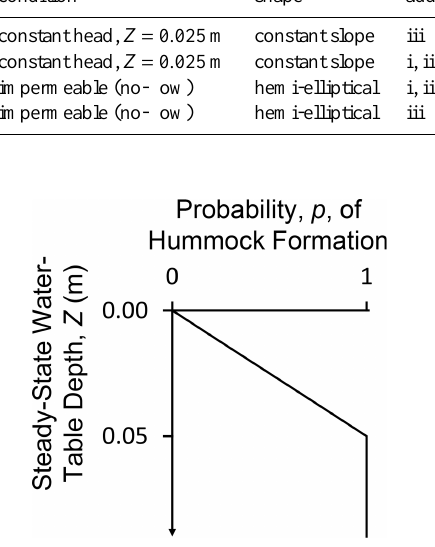
Figure 2. Time series of daily-average absolute water-table change per grid square during five-year test periods with Models 1, 2 and 3. See main text for full details. Note the logarithmic scales on both axes.